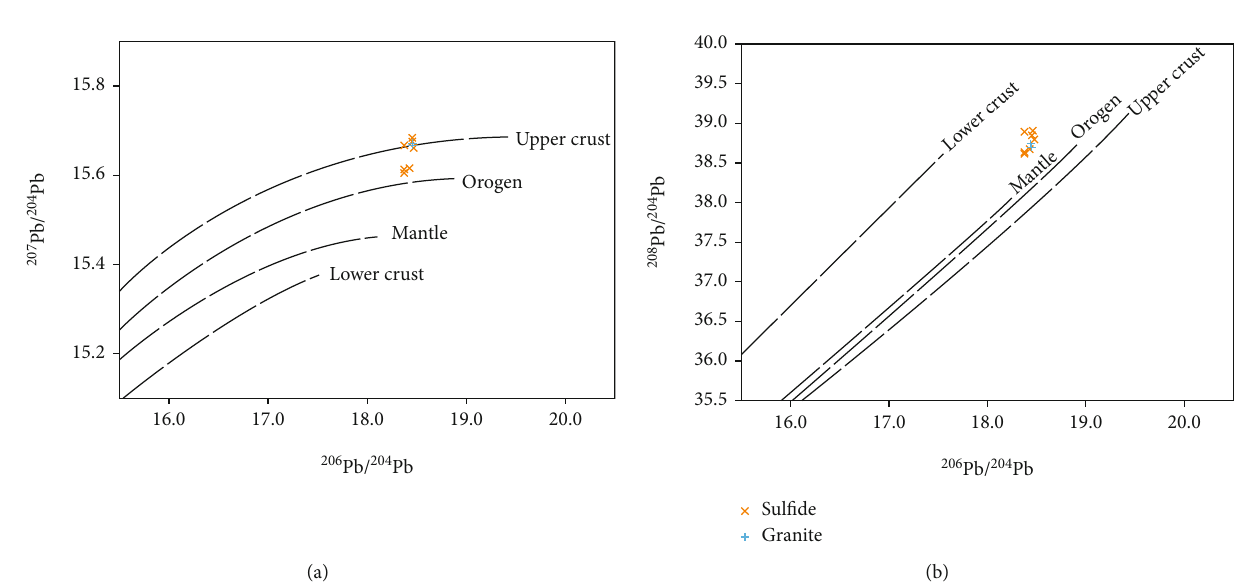
Figure 10: Plot of 207 Pb/ 204 Pb versus 206 Pb/ 204 Pb (a) and 208 Pb/ 204 Pb versus 206 Pb/ 204 Pb (b) for the sul fi des and granodiorite from the Xinmin